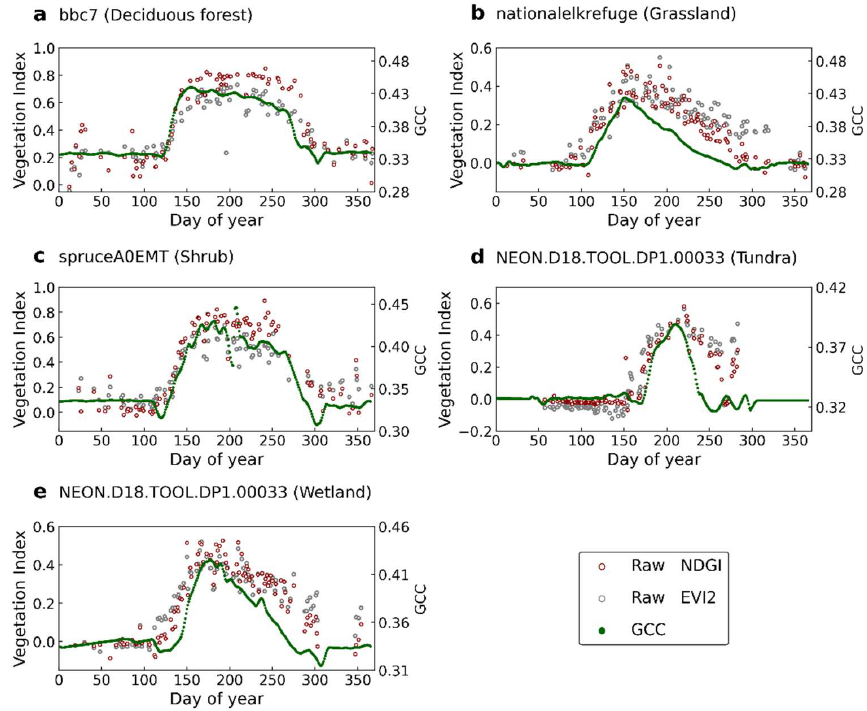
Figure 2. The time series of the NDGI (red), EVI2 (gray), and GCC (green) at five locations with different vegetation types. Dots are raw observations from the SGLI. Green dots indicate the GCC obtained from near-surface observation data.